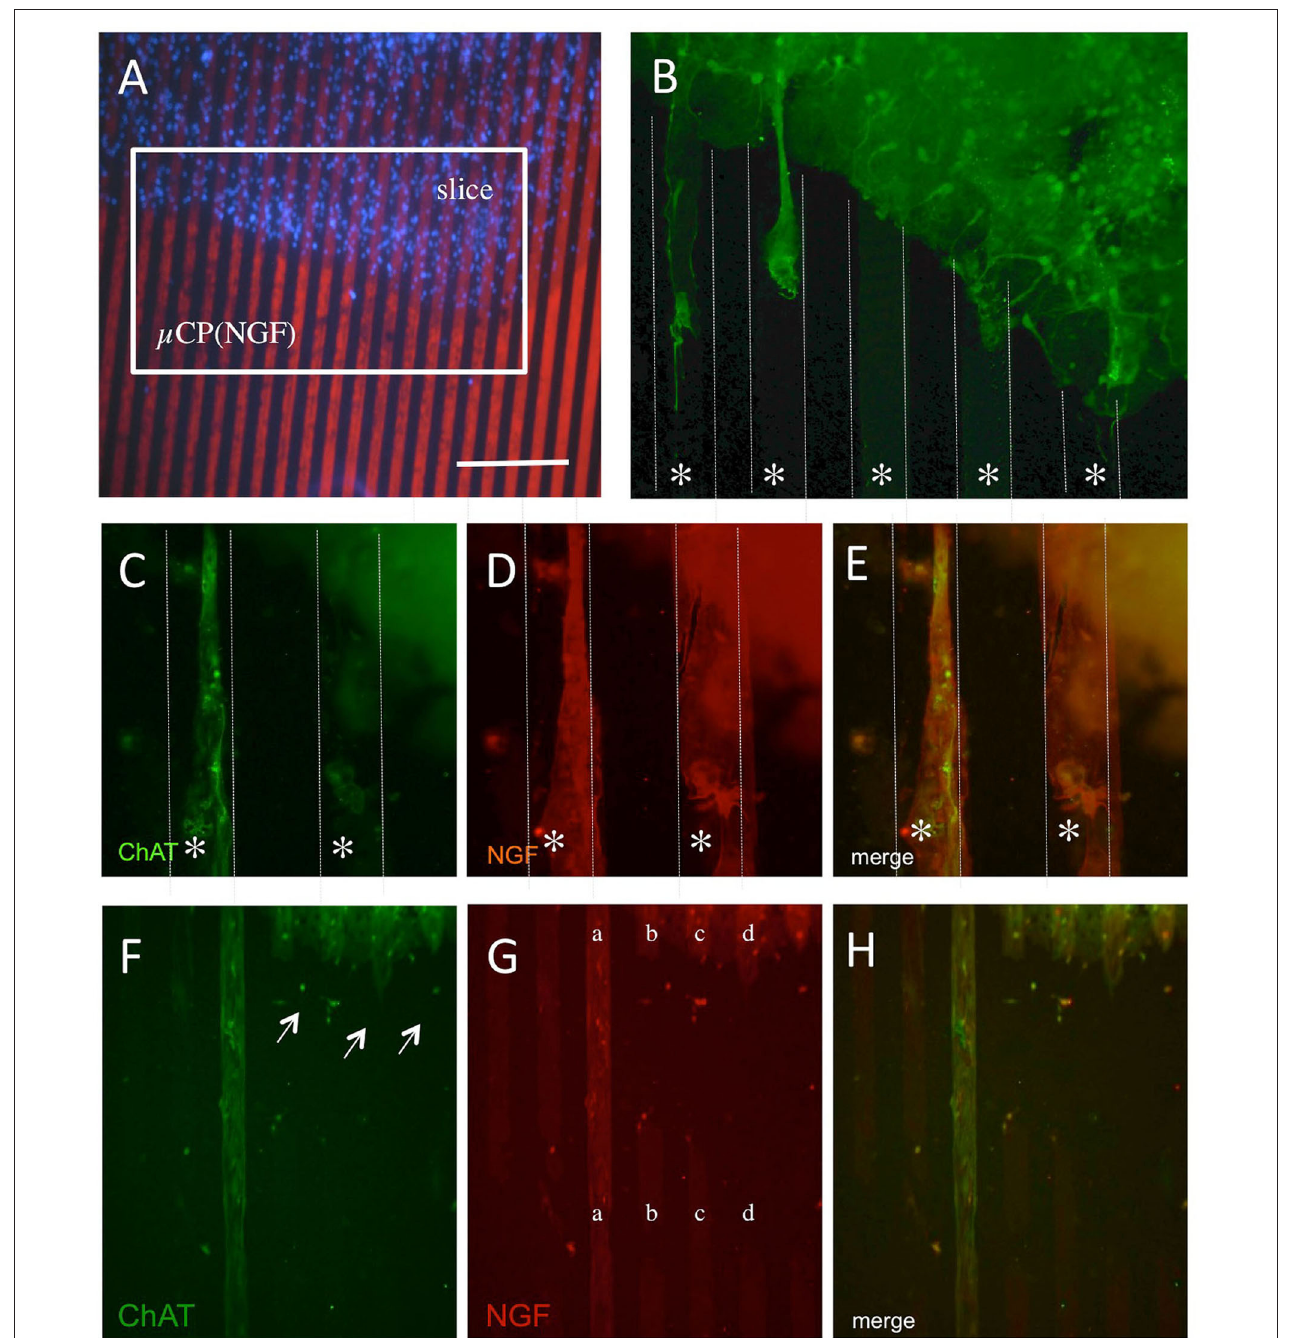
FIGURE 4 | The outgrowth of cholinergic neurons from the brain slices coupled with NGF microcontact prints ( µ CP). Brain slices (300 µ m thick) of the nBM were prepared and connected to the NGF µ CP, incubated for 1 week with 100ng/ml of NGF in the medium, and then further for 2 weeks without NGF. The slices were fixed and stained for ChAT and Alexa-488 (green) and the ChAT processes were evaluated at the borders of the slices (A) . (B) The outgrowth of ChAT + neurons along the µ CP (white lines, star *). Three typical outgrowths are seen, thin axons, but also thicker processes. (C–E) A typical example of an outgrowth of ChAT + nerve fibers [ (C) , green, Alexa-488], co-stained with an anti-NGF antibody [ (D) , red, Alexa-546]. (E) Shows the merged picture and that the ChAT + nerve fibers grow along the NGF µ CP. (F–H) The selectivity of growth along the µ CP. (G) An example of an incomplete printing (lanes b–d), while on a complete print, (lane a) the ChAT + processes are seen [ (F) , arrows]. Quantitative analysis shows the outgrowth of 24 ± 2 ChAT + nerve fibers per slice with a length of 286 ± 35 µ m after 3 weeks in culture. Ten brain slices were prepared from five animals. Scale bar in A = 270 µ m (A) , 60 µ m (B) , 54 µ m (C–E) , 108 µ m (F–H) .